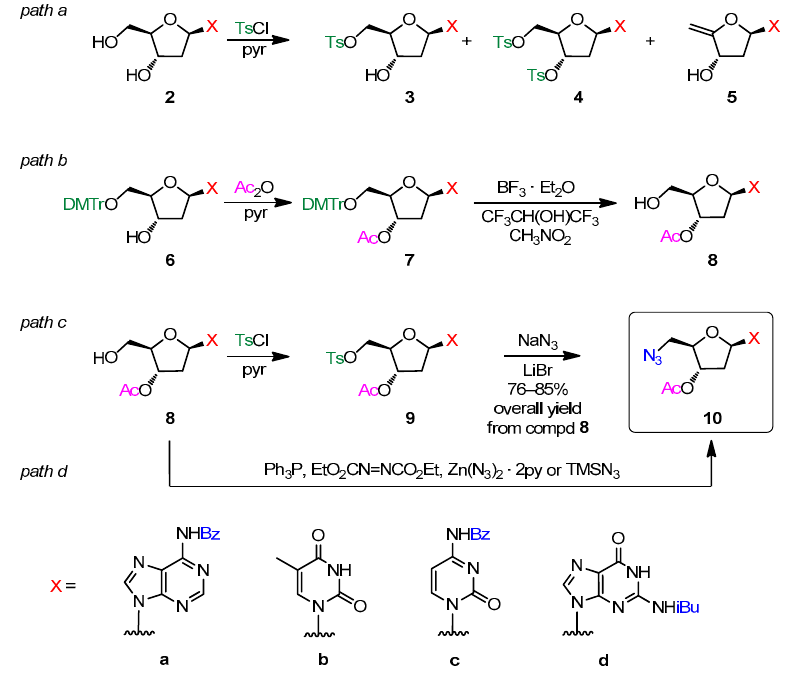
Scheme 1. Synthesis of